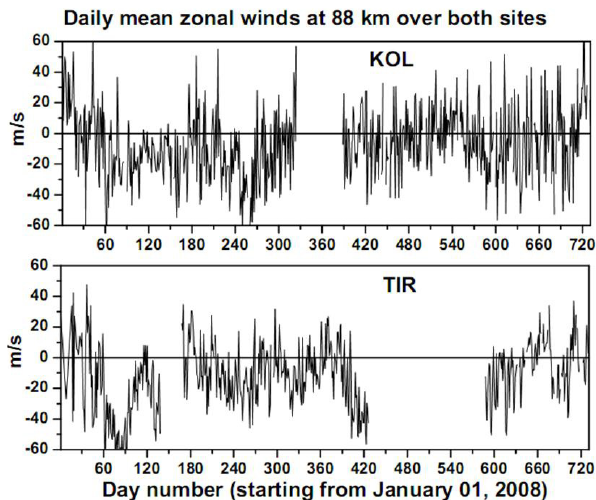
Fig. 1. Time series of daily mean zonal winds at 88km altitude over Kolhapur (KOL) (top plot) and Tirunelveli (TIR) (bottom plot) for the observational period 1 January 2008–31 December